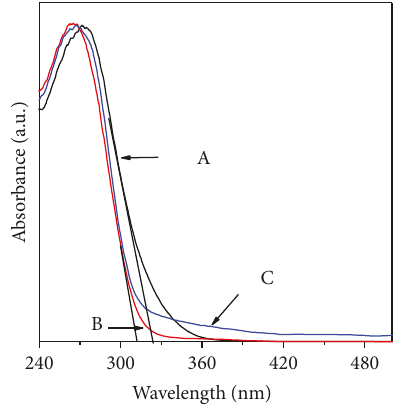
Figure 3: UV-vis spectra of samples prepared from di ff erent